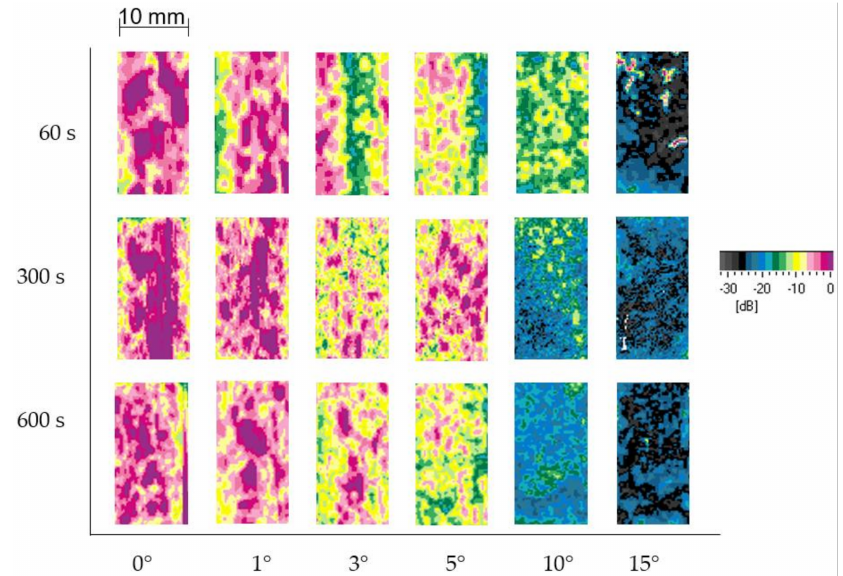
Figure 11. Ultrasonic C-scans from the back side of samples with various out-of-plane fibre angles after hot-air treatment for 60 to 600